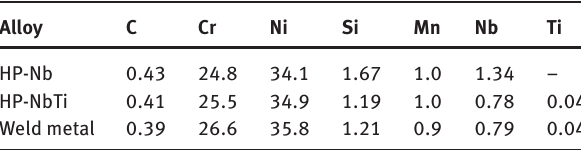
Table 2: Chemical composition of the HP-Nb and HP-NbTi alloys and weld metal (wt.%) [5].